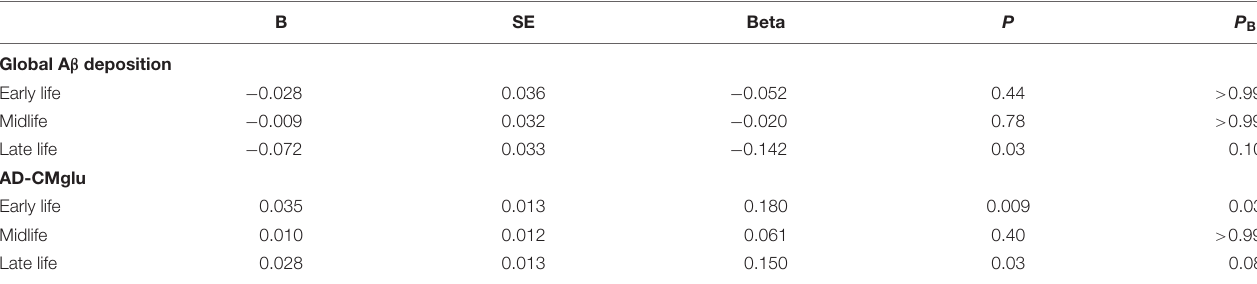
TABLE 2 | Association between cognitive activities (CAs) in each life period and global cerebral amyloid-beta (A β ) deposition and Alzheimer’s disease signature region cerebral glucose metabolism (AD-CMglu). B SE Beta P P B